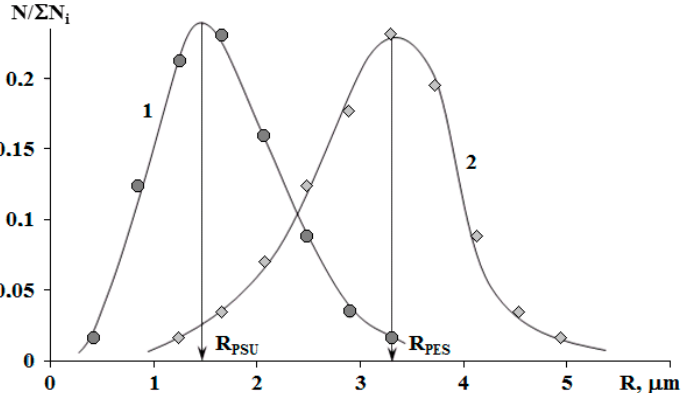
Figure 10. Size distribution of phases in the cured mixtures PSU–EO (1) and PES–EO (2) with 5 wt.% of TP. R PSU and R PES are the average sizes of heterogeneous particles in the PSU–EO and PES–EO systems, respectively.